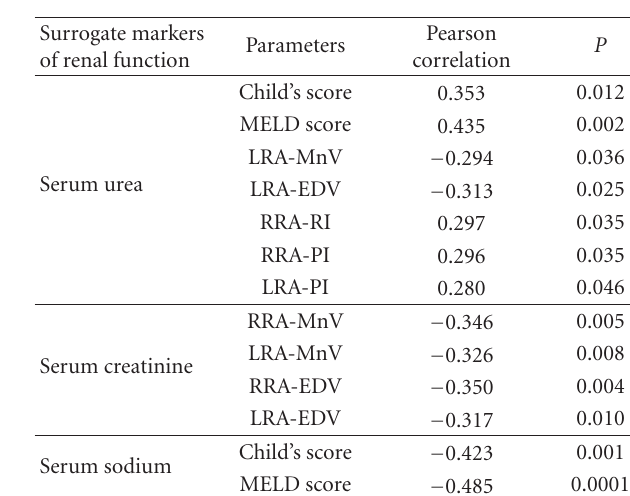
Table 7: Significant correlations between surrogate markers of renal function and Childs and MELD scores, and renal Doppler US